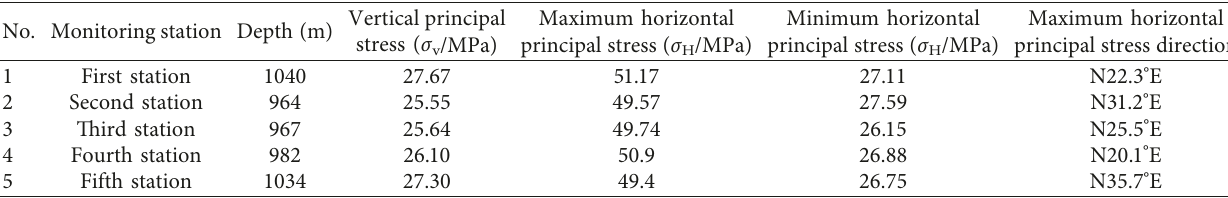
Figure 2: Macroscopic storage structure profile of No. 3 coal seam. Table 1: Results of geostress